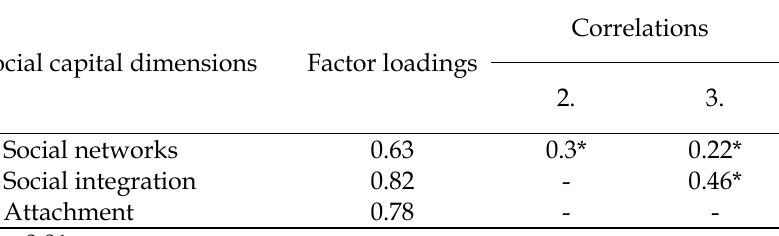
Table 3. Factor loadings and correlations of the three social capital di-